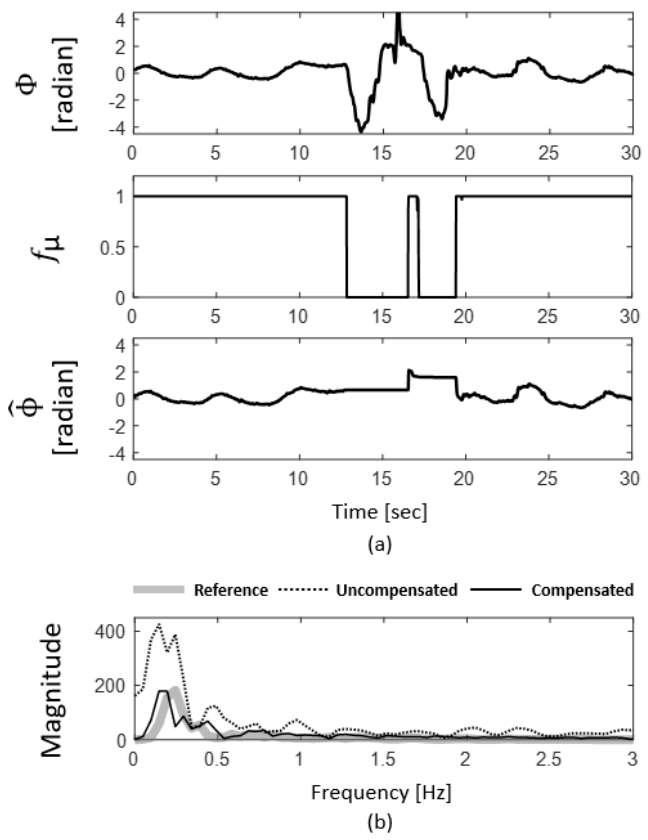
Figure 4. Components comparison of respiration signal based on compensation. ( a ) Compensation of distorted phase components of respiration signal, ( b ) comparison of frequency components of respiration signal according to the distortion compensation .